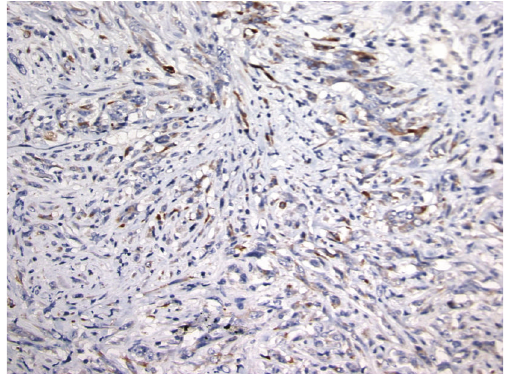
Figure 5: The tumor cells displayed di ff use immunoreactivity for β -hCG.